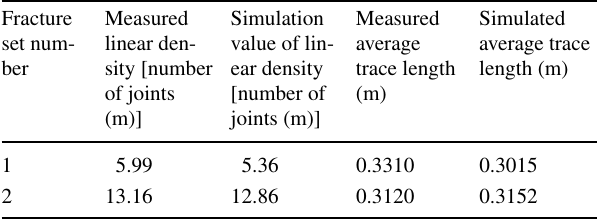
Table 2 Comparison of the measured and simulated data of the frac- tures in the shale outcrop in the Shihuigou area Measured Fracture linear den- set num- ber